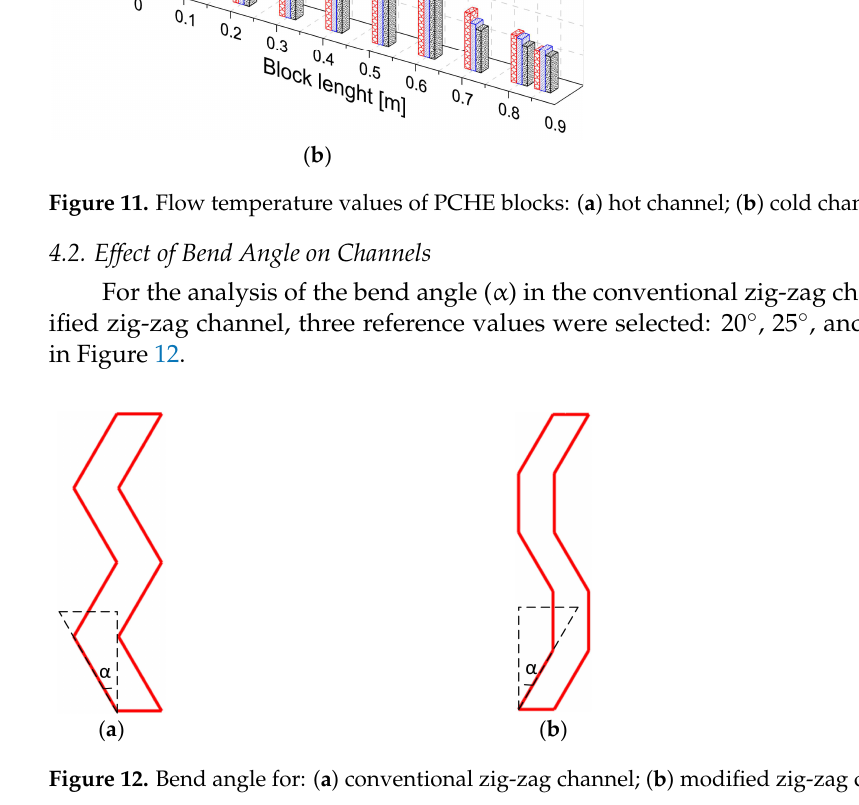
( b ) Figure 13. Effect of bend angle on pressure drop: ( a ) conventional zig-zag channel; ( b ) modified zig- zag channel. The change in the friction factor due to the bend angle is shown in Figure 14. Unlike the pressure drop, it was observed that the friction factor tends to decrease with the in- creasing mass flow. This result can be attributed to the flow regime in the PCHE channels. However, the increase in the bend angle tends to increase the friction factor in the conven- tional zig-zag channel and the modified zig-zag channel. This is a consequence of the greater difficulty for the flow to circulate inside the channels.